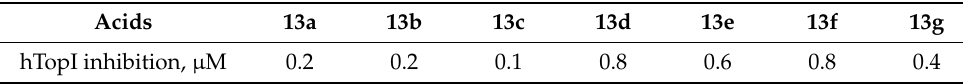
Table 2. Inhibitory activity of trienoic acids 13a – g in vitro.